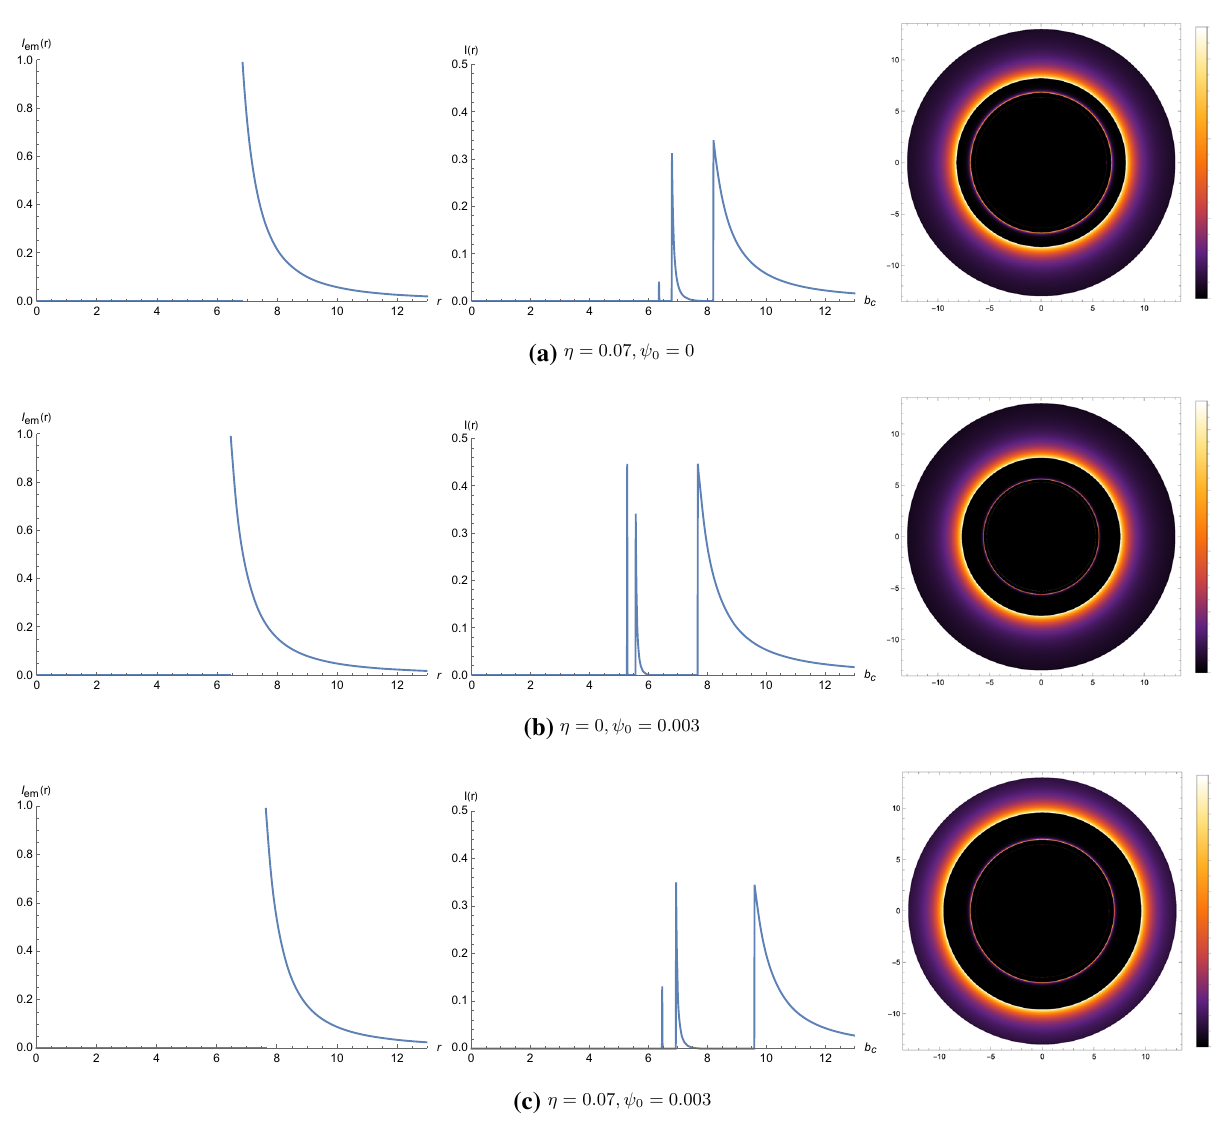
Fig. 5 Observational appearances of the thin disk for the function I (cid:5) intensities of direct emission and rings. The related shadows and rings are clearly presented at the right column of Fig.